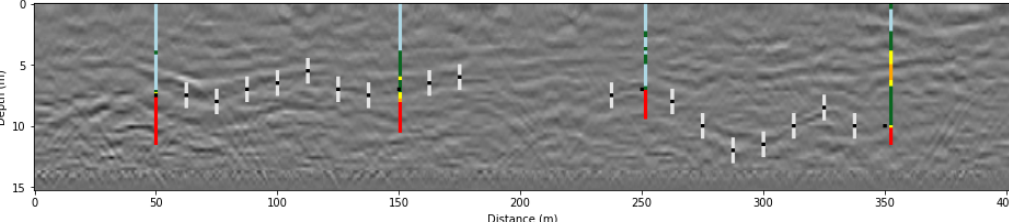
Figure 6. Augmented GPR image overlaid with geologist estimations of the boundary transition. The geologist identified several locations along the GPR track where they believe the boundary exists and provided a measure of uncertainty in their estimations.